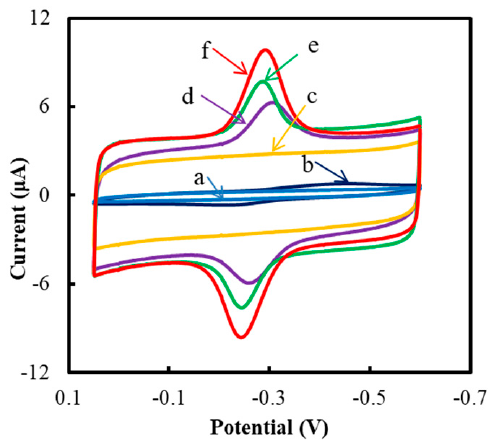
Figure 1. Cyclic voltammograms (CVs) of different modified GCEs: ( a ) bare GCE, ( b ) NF/GluOx/mPEG, ( c ) NF/IL/mPEG-fMWCNTs, ( d ) NF/GluOx/mPEG-fMWCNTs, ( e ) NF/GluOx/IL/fMWCNTs, and ( f ) NF/GluOx/IL/mPEG-fMWCNTs. The experiments were conducted in a sodium phosphate- buffered saline solution (PBS) (50 mM, pH 7.0) at a scan rate of 0.05 V/s. The CVs of the NF/GluOx/IL/mPEG-fMWCNTs modified GCE at different scan rates are